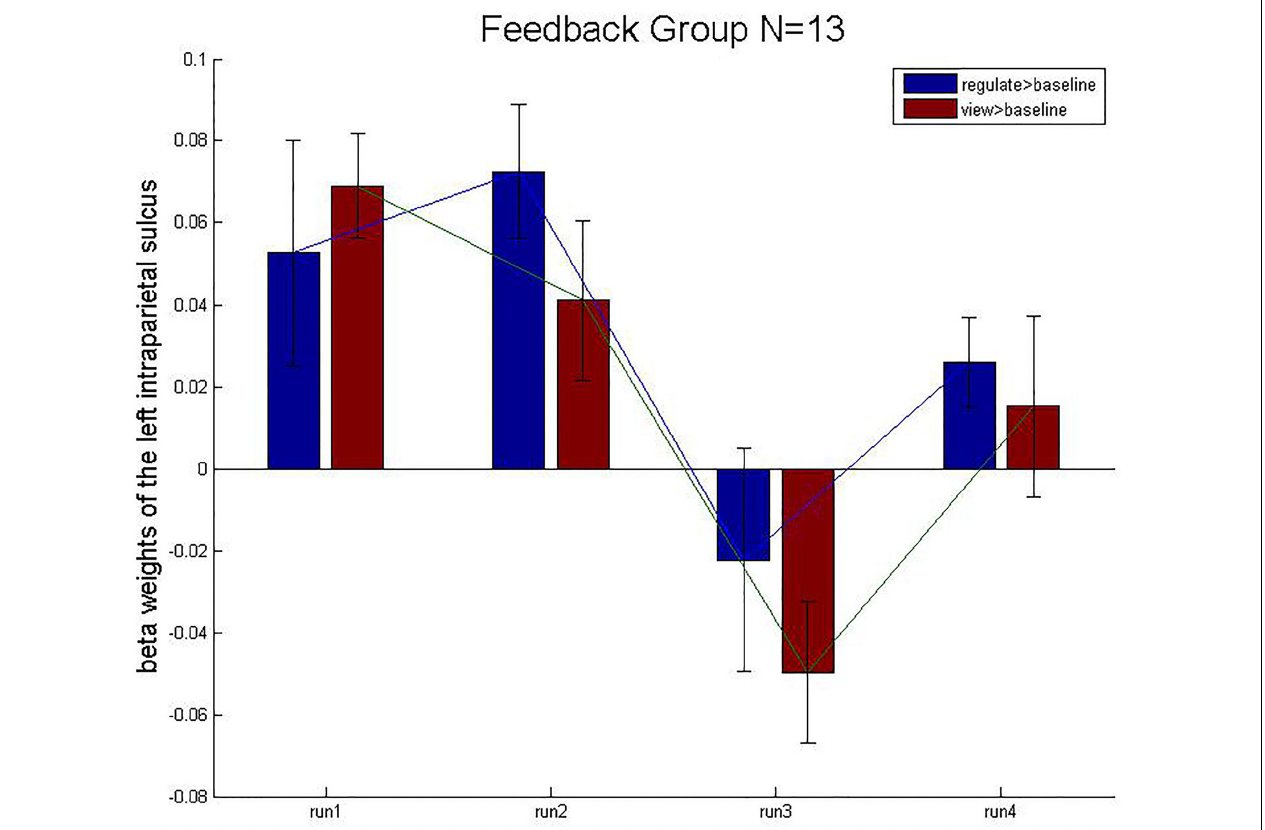
FIGURE 9 | Mean beta weights of the subject’s localizer the intraparietal sulcus ROIs. Conditions regulate > baseline (blue) and view > baseline (red) are presented during the four runs. Error bars represent the standard